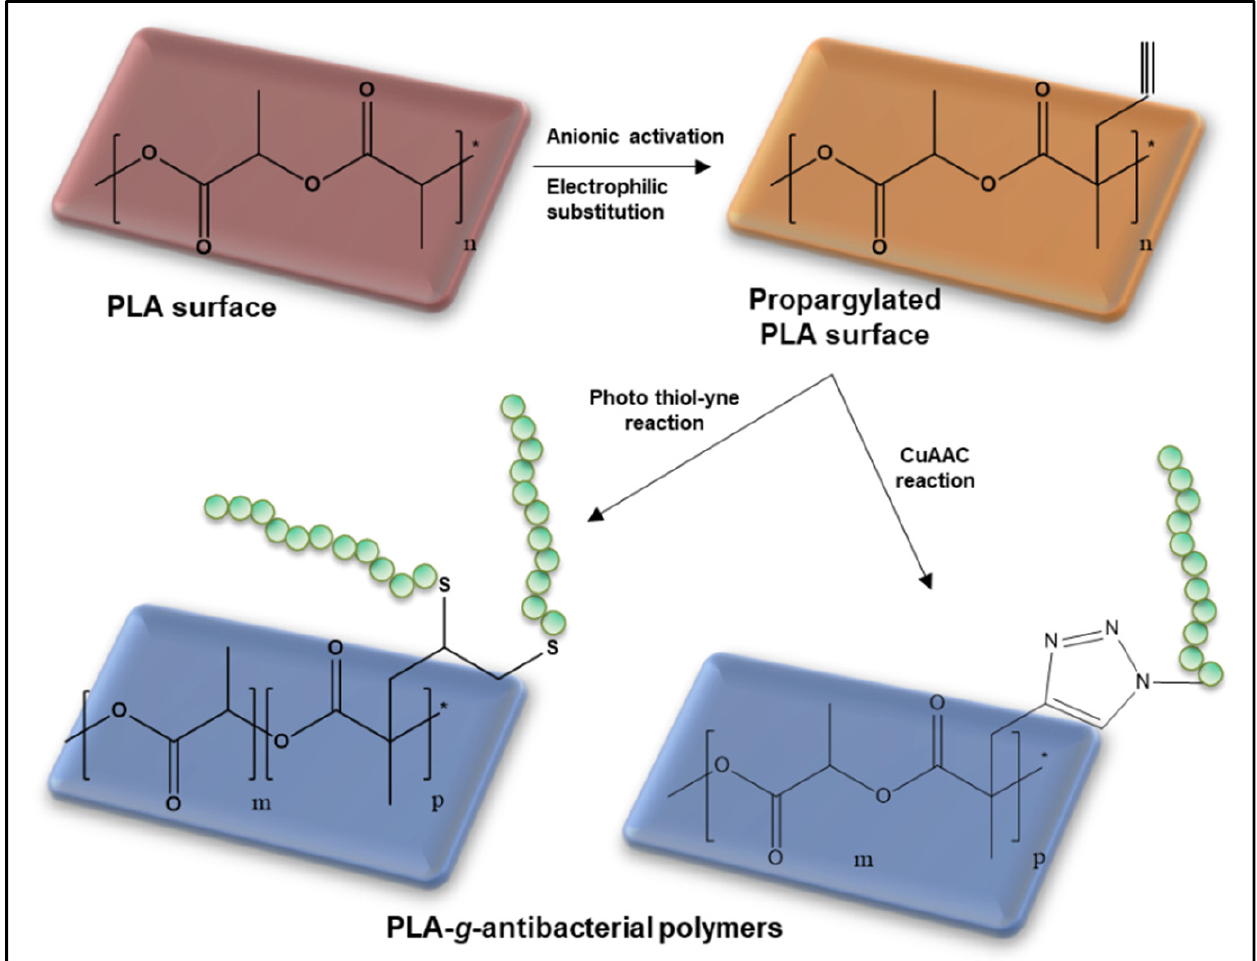
Figure 21. General synthesis scheme of PLA- g -antibacterial polymers from propargylated PLA sur- face (adapted from Sardo et al. [102] and El Habnouni et al. [101]).